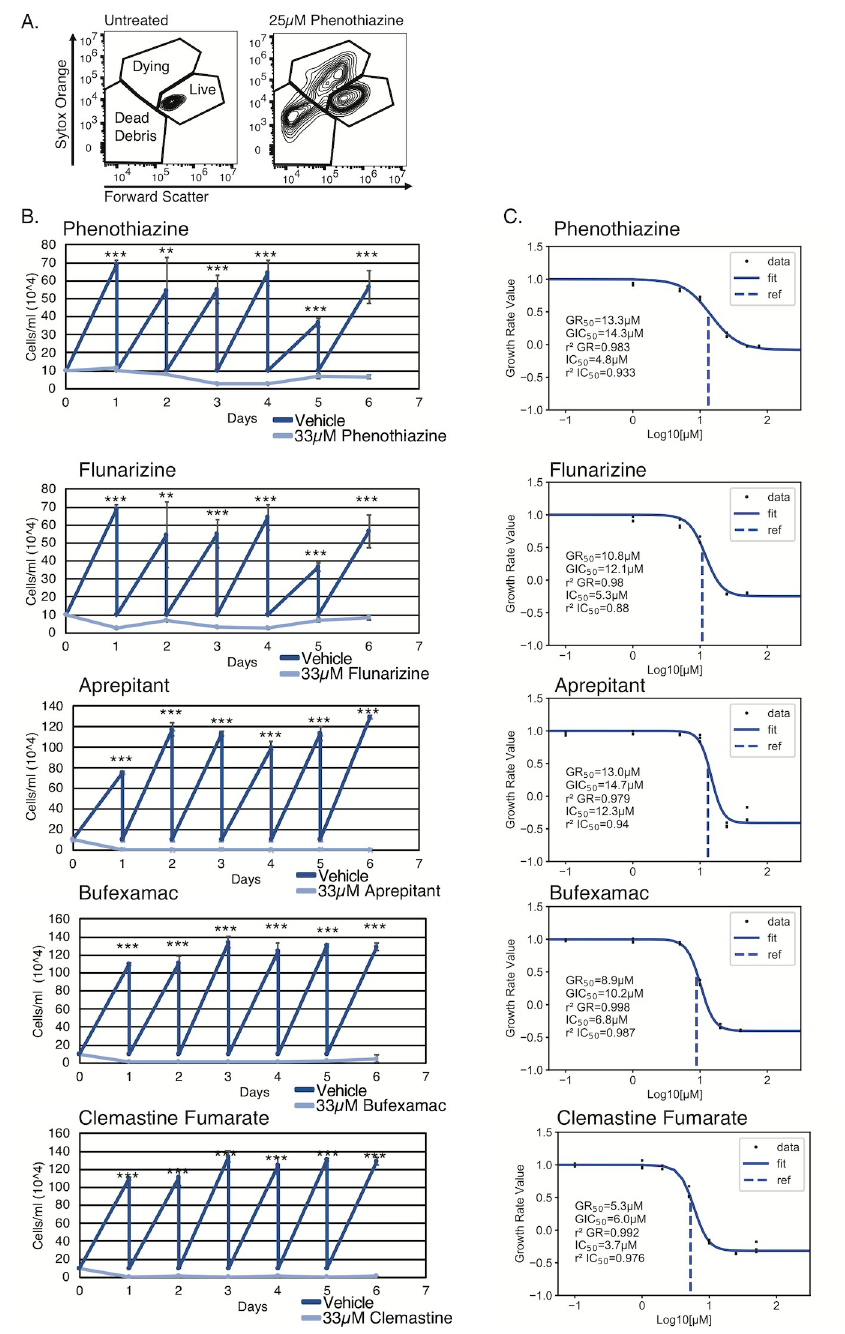
Fig 1. Confirmation of growth inhibition for a subset of drugs identified in the drug screen. (A) Flow cytometry plot showing forward scatter vs Sytox Orange staining to illustrate how live cells were gated. (Left) untreated parasites, (Right) parasites treated with 25 μ M phenothiazine. (B) Growth curves of parasites treated with the indicated drugs or vehicle control over a period of 6 days. Dark blue, vehicle control treated cells, Light blue, drug treated cells. Error bars indicate standard deviation of 3 biological replicates. � , �� , ��� indicates p < 0.05, p < 0.01, and p < 0.001 respectively as measured by an unpaired two-sided Student’s T test. (C) Percent growth inhibition over a range of concentrations for the indicated drug. Data were fitted and indicated values calculated using the GRMetrics R package. GR 50 , the concentration at which the effect reaches a growth rate (GR) value of 0.5 based on interpolation of the fitted curve (dashed lines). GIC 50 , the drug concentration at half-maximal effect for calculated growth rate. r 2 GR, the coefficient of determination for how well the GR curve fits to the data points. IC 50 , the concentration at which relative